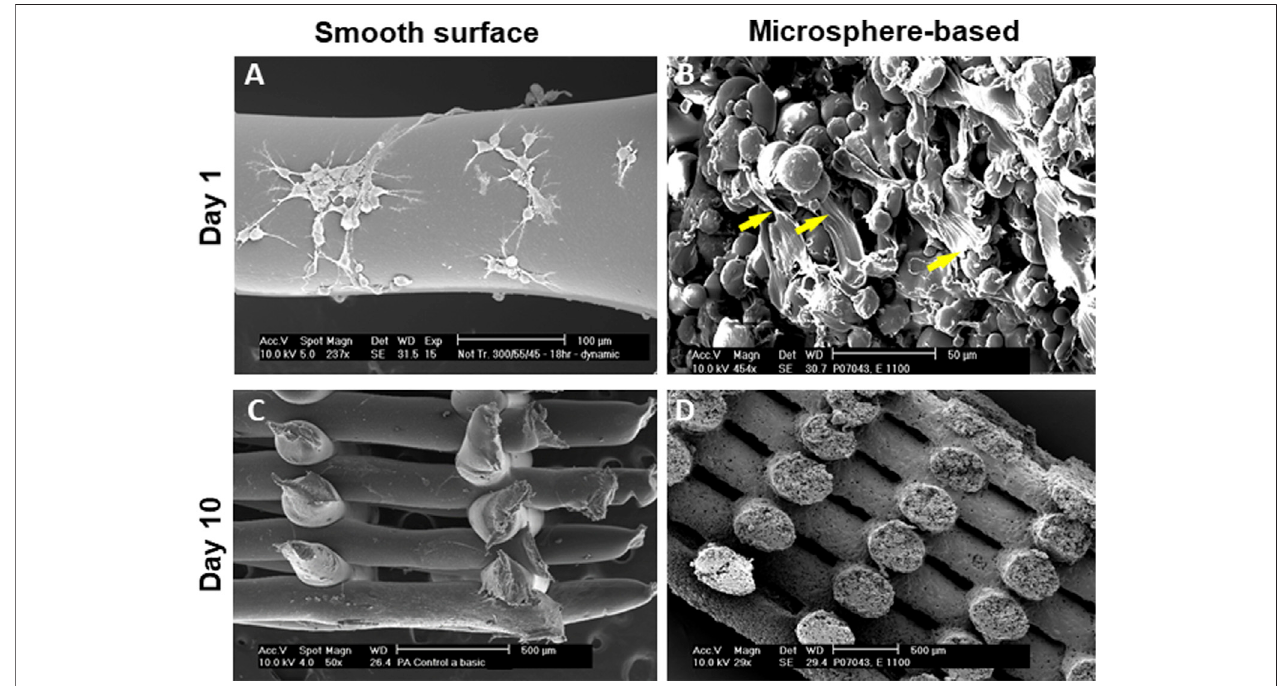
FIGURE 5 | SEM images of cells cultured on 3D fi bers. (A,C) Cells cultured on smooth scaffolds showed scarce proliferation overtime with round morphologies. (B,D) Cells cultured on microspheres-based scaffolds showed higher levels of proliferation with elongated morphologies with numerous fi lamentous extensions (yellow arrows). Scale bars: (A) 100 μ m; (B) 50 μ m; (C) ; (D) 500